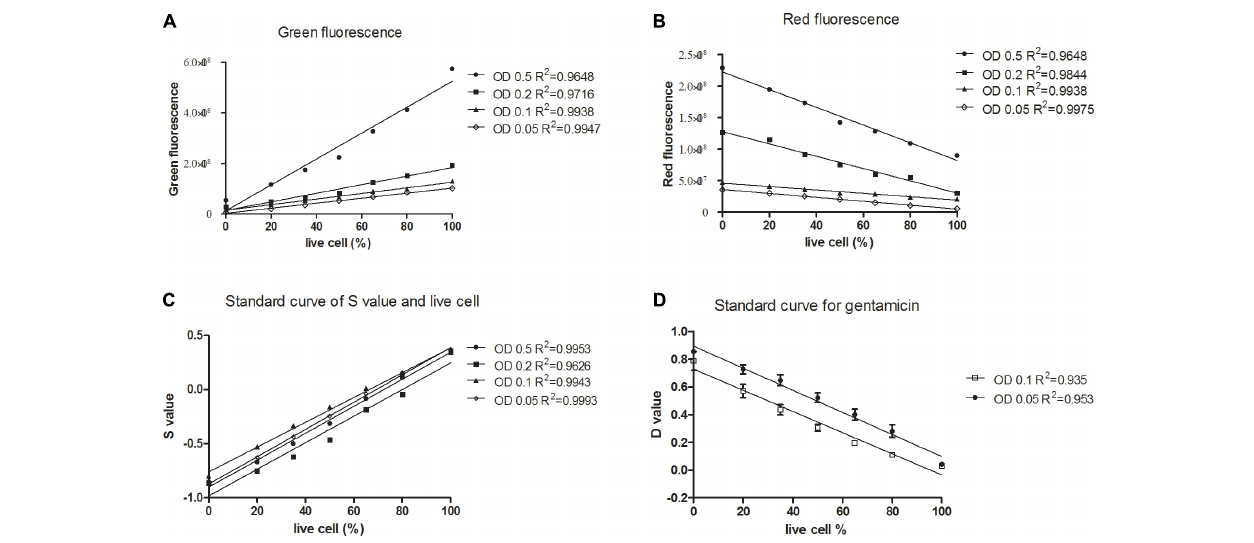
FIGURE 1 | Linear relationship between the percentages of live or membrane impermeable cells and the green/red fluorescence, and S and D values calculated from the SYBR Green/PI viability assay for Klebsiella pneumoniae . Known proportions (0, 20, 35, 50, 65, 80, and 100%) of isopropyl killed and live Klebsiella pneumoniae of a clinical isolate were diluted into different concentrations, stained with SYBR Green/PI and measured using a fluorescence plate reader. Linear regression lines were determined between the percentage of live cells and (A) green fluorescence intensity, (B) red fluorescence intensity. (C) Membrane permeability values ( S ) of an isolate were calculated and linear regression lines were determined between the percentage of live cells and the S values. (D) Death cell values ( D ) of three clinical isolates were calculated and linear regression lines were determined between the percentage of live cells and the D values.